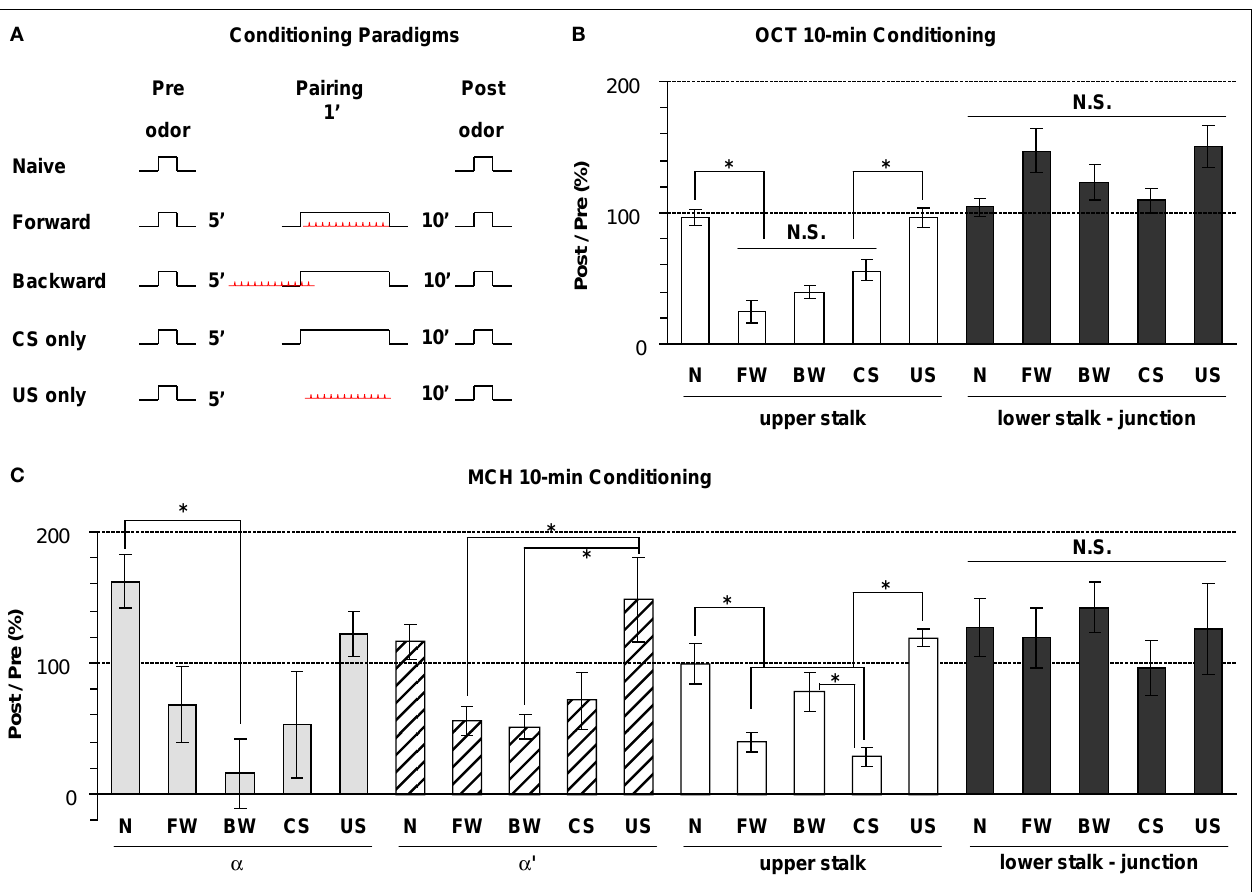
FIGURE 8 | Odor response properties of the dopaminergic neurons innervating the lobes after pairing odor with electric shock. (A) Training paradigms including naïve, forward, backward, CS-only, and US-only. For each fl y, odor was presented for 3 s at 5 min prior to conditioning and the calcium responses were monitored. The odor was presented again at 10 min after conditioning and the calcium responses were again monitored. Flies were trained between the Pre and Post presentations of odors and the percentage ratio of the Post/Pre response determined and plotted in panels (B,C) . (B) Responses in the upper stalk and lower stalk/junction 10 min after conditioning with 0.3% octanol (OCT) and 0.01 mA electric shock. n = 10–21 for each group. Data represents mean ± SEM. *Indicates signifi cant difference ( p < 0.0001). Forward, backward, and CS-only conditioning each reduced the subsequent calcium response to odor in the upper stalk region. There were no signifi cant